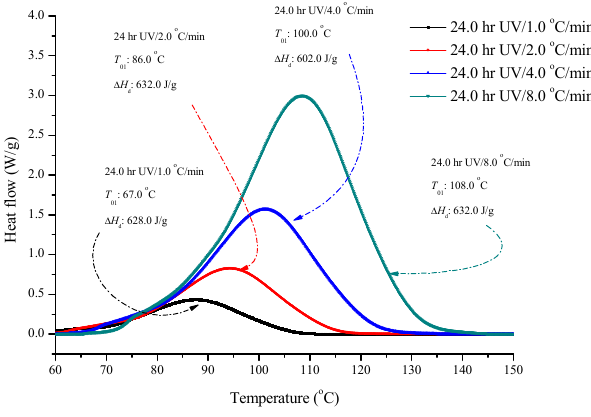
Figure 7. DSC thermal curves of ADVN with 24 h UV at heating rates of 1, 2, 4 and 8 °C/min.